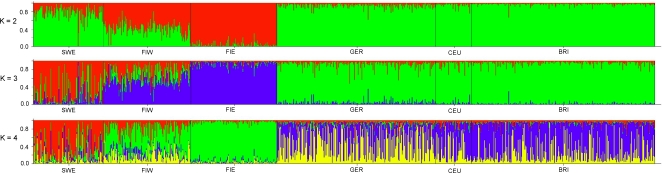
The Structure results for two, three and four clusters.Each individual is represented by a thin vertical line, and colours denote the clusters. Abbreviations as in Figure 1. The probabilities of the different clusterings are given in Supplementary Figure 2b.